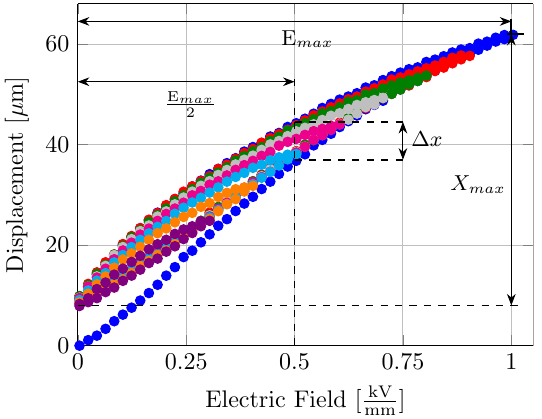
Figure 4. Uni-polar Strain–Electric field curve measured at successively decreasing maximum electric field strengths, showing the intrinsic hysteresis and remnant